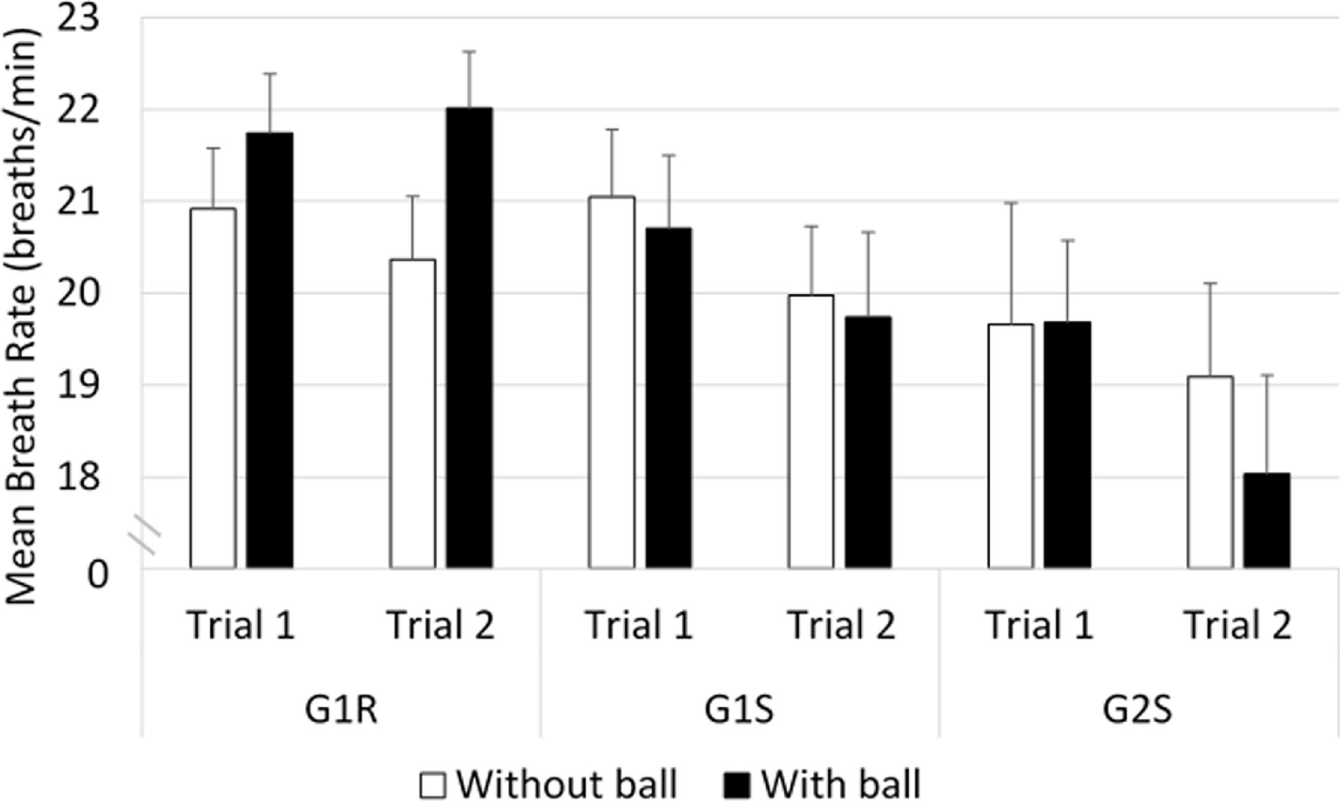
Fig 13. Mean breathing rate.